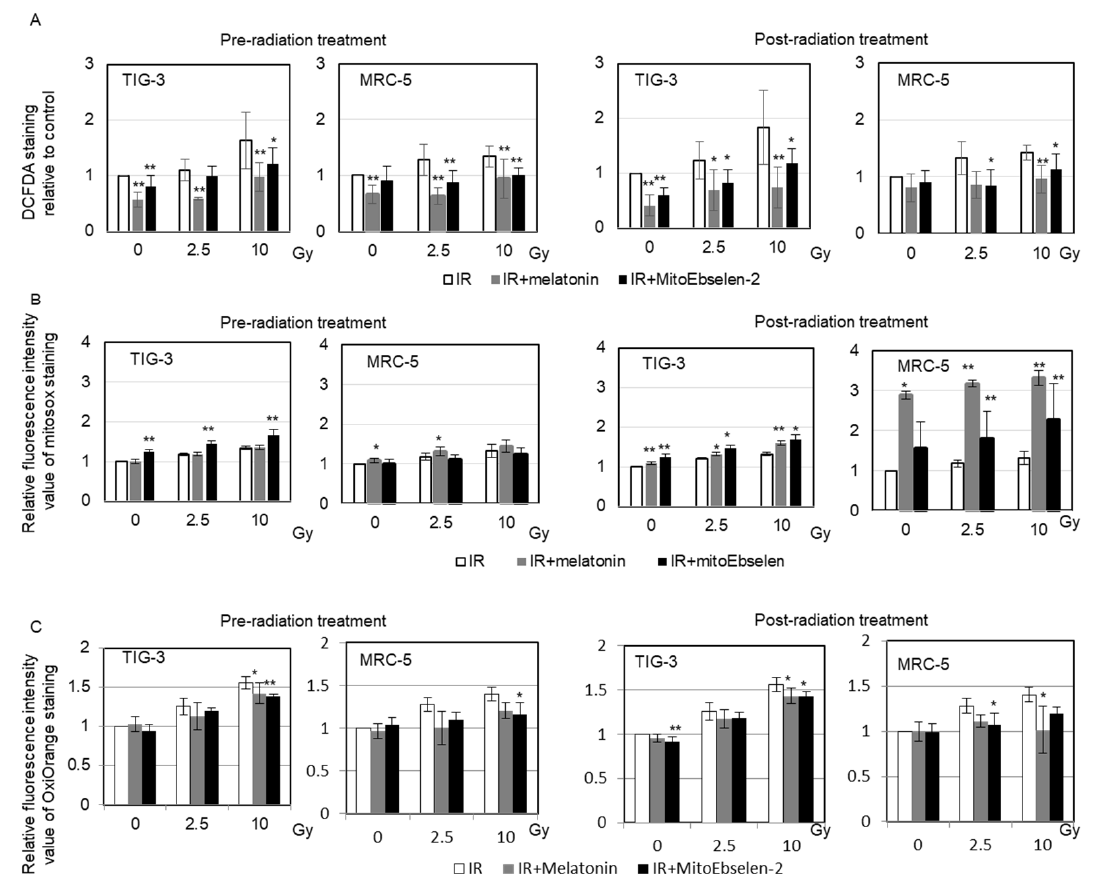
Figure 2. Measurements of the intracellular redox state, mitochondrial ROS and • OH. The relative fluorescence intensity values of the DCFDA ( A ), MitoSOX-red ( B ), and OxiORANGE ( C ) were normalized to non-irradiated controls. TIG-3 and MRC-5 cells were stained 1 day after X-ray exposure. Asterisk indicates a significant change in fluorescence intensity value of the staining in IR+ melatonin group and IR+ MitoEbselen-2 group compared with that of IR groups at same Gy level. 3.3. Mitigating Radiation Effects on Cell Growth Suppression by Treatment with Melatonin or MitoEbselen-2 The number of cells in TIG-3 cells was counted 3 days after irradiation to evaluate the protective role of melatonin and MitoEbselen-2 on cell growth (Figure 3A). When cells were exposed to radiation doses >2.5 Gy, their growth was inhibited in a dose-dependent manner. In contrast, melatonin-treated cells showed growth inhibition at >5 Gy, but MitoEbselen-2-treated cells showed no growth retardation. Thus, combining radiation with melatonin or MitoEbselen2 reduced the effect of radiation on cell growth. Similar results were obtained in MRC-5 cells (Supplementary Figure S1). Radiation-induced DNA double strand breaks were examined by using a marker γ -H2AX. γ -H2AX foci were found 24 h after 10-Gy irradiation (Figure 3B). In contrast, pre-radiation and post-radiation melatonin or MitoEbselen-2 treatment did not significantly increase γ -H2AX fluorescence levels (Figure 3C). We further examined the Nrf2-mediated antioxidant response. Radiation alone activated Nrf2, as evidenced by nuclear accumulation of Nrf2 in TIG-3 cells (Figure 3B). Radiation with pre-radiation and post-radiation melatonin or MitoEbselen-2 treatment did not induce such Nrf2 radiation responses (Figure